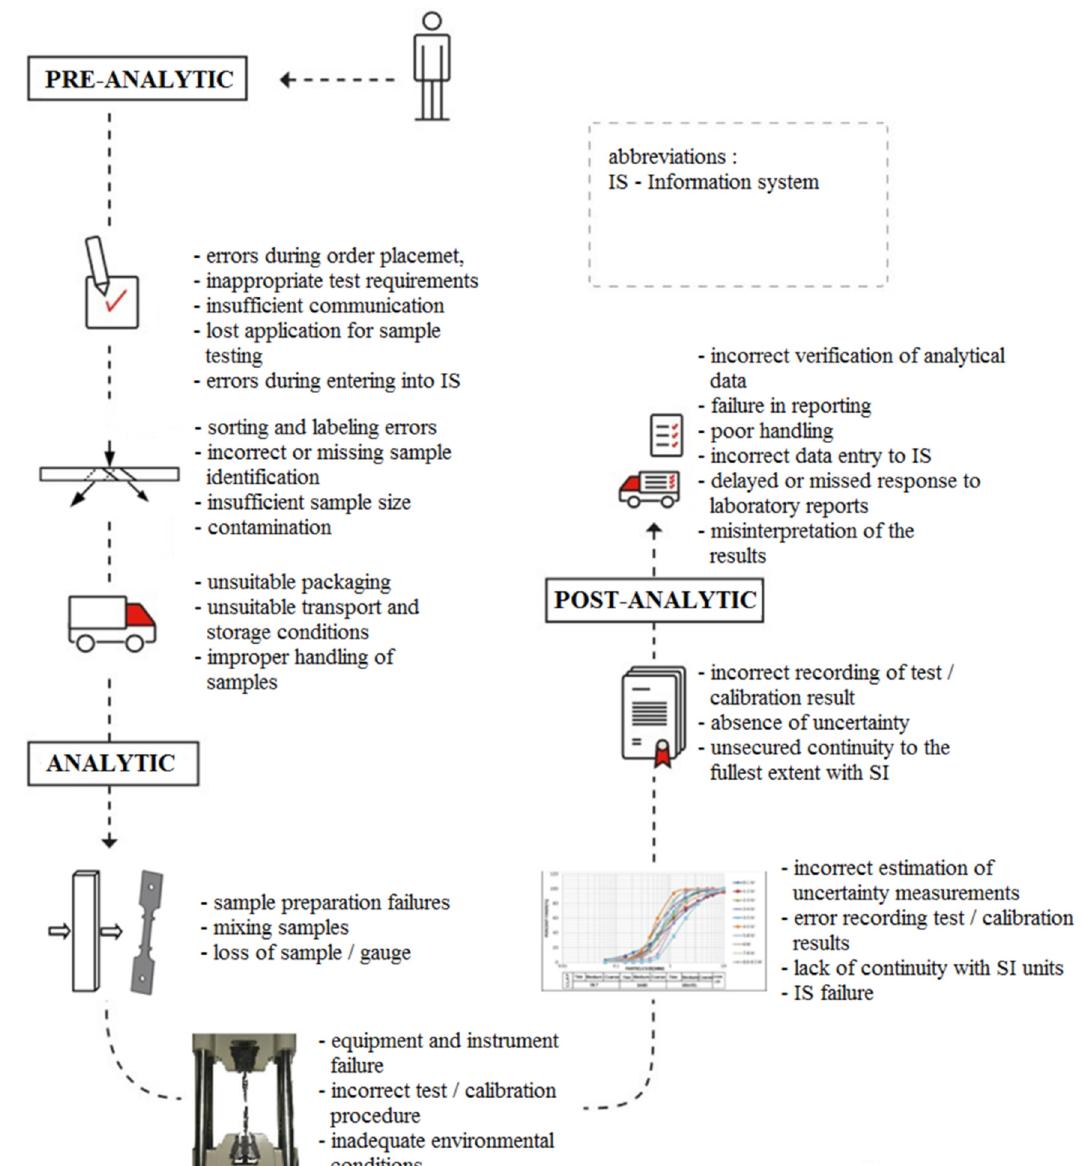
Figure 3. Failures in the phases of the laboratory testing process.